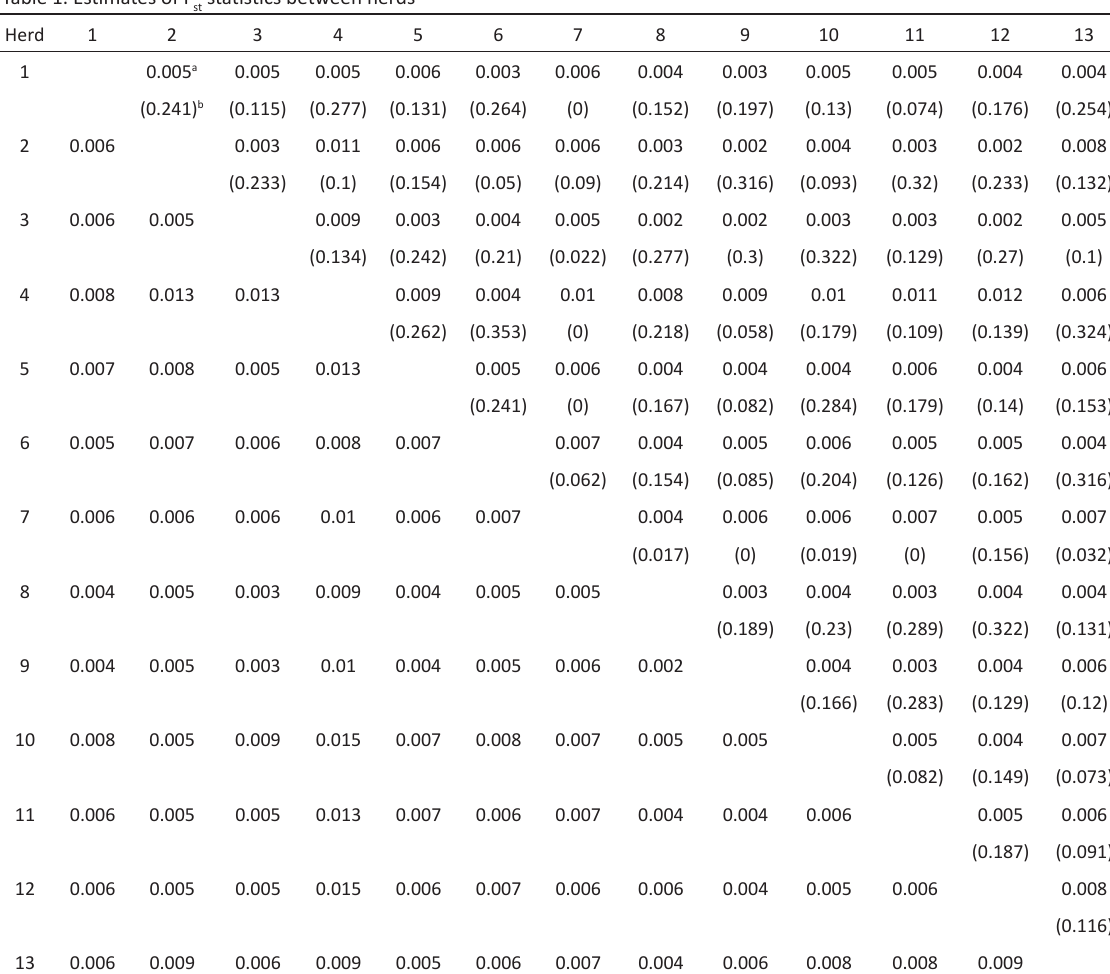
Table 1. Estimates of F